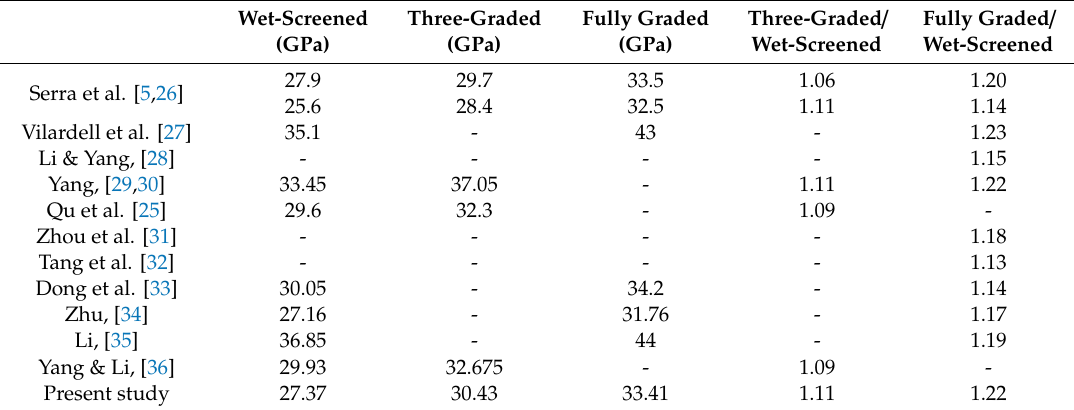
Table 6. A comparison of the elastic modulus of mass concrete with reference to the wet-screened concrete from test and numerical